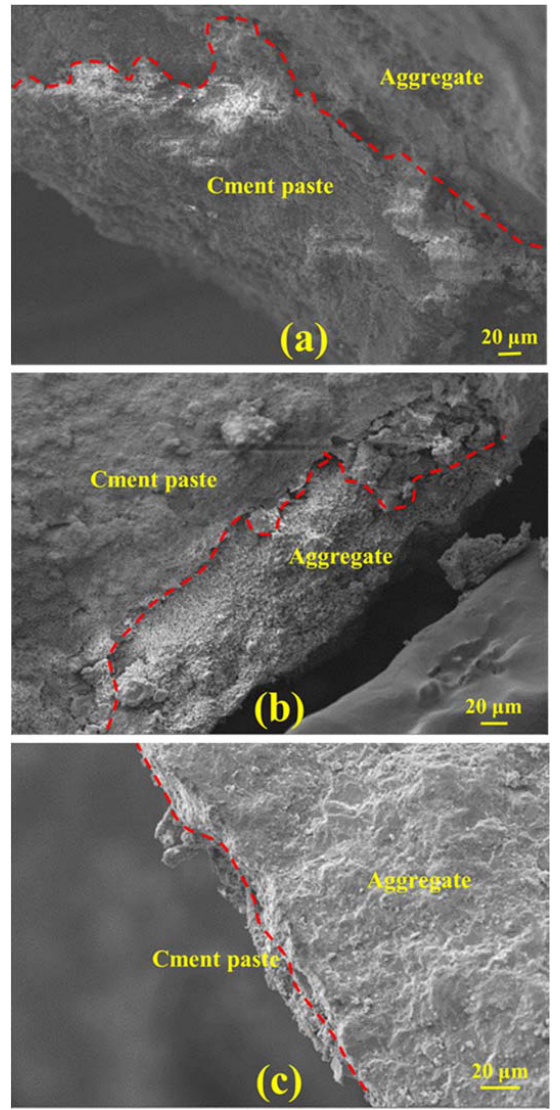
Figure 8. SEM images of the aggregate edge in porous mortar prepared with paste fluidities of ( a ) 160 mm, ( b ) 190 mm, and ( c ) 200 mm. The contour line of the WPC versus cement paste fluidity and paste ‐ to ‐ aggregate ra ‐ tio is shown in Figure 9b, and was determined by the response surface versus the same factors as illustrated above (Figure 9a). For a given paste ‐ to ‐ aggregate ratio, the WPC val ‐ ues decreased with increasing cement paste fluidity from 160 mm to 200 mm. This obser ‐ vation was not surprising given the highly correlated linear relationship between the in ‐ terconnected void ratio and paste fluidity, as observed in Figure 1, and the linear correla ‐ tion between the WPC and the interconnected void ratio, as shown in Figure 3b (PF as the single variable experimental results, correlation coefficient 0.96) as well as Figure 10 (PF and P/A double variables experimental results, correlation coefficient 0.92). The intercon ‐ nected void ratio for the various designs in Table 4 is presented in Figure 11. At very low